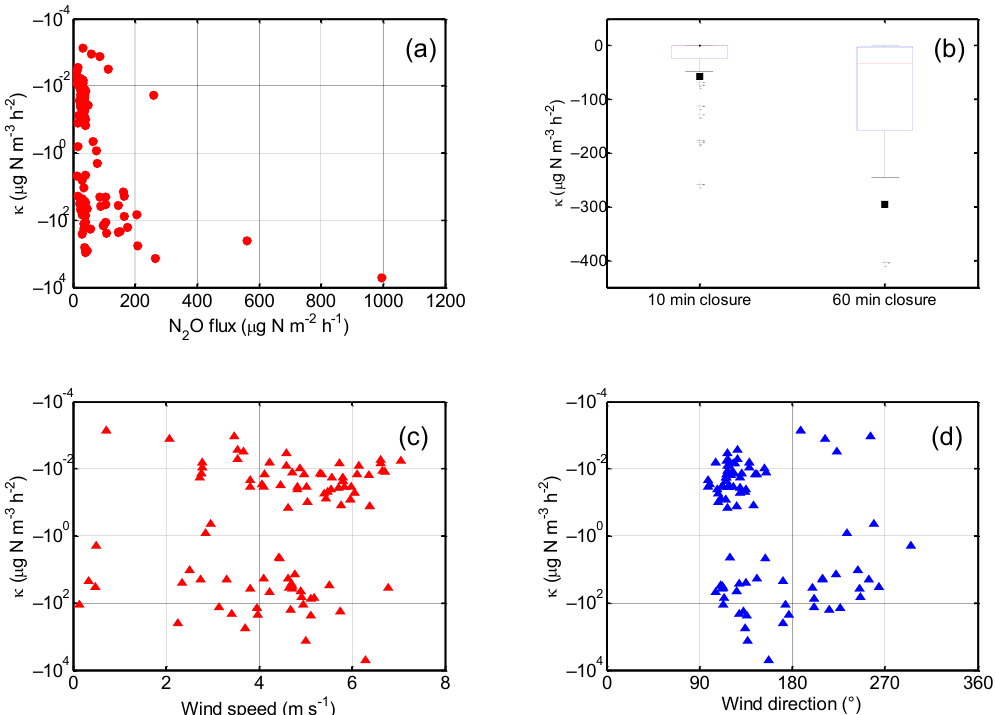
Figure 3. (a) Relationship between κ and N 2 O fluxes calculated with an exponential model (see text for details). The parameter κ indicates the curvature, i.e., the second derivative of the exponential model used for flux calculation. Negative κ values correspond to concave functions, i.e., plateauing (saturating) N 2 O concentration increases (cf. Fig. 2). (b) Box plot of κ values showing the difference between 10 and 60min closure where black squares represent the arithmetic mean, red horizontal lines indicate the median, blue horizontal lines indicate lower and upper quartile values, black whiskers represent the interquartile range, and outliers from this range are plotted as grey crosses. To ensure better readability, the y axis is truncated at − 450µg Nm − 3 h − 2 . Thus, some outliers between − 450 and − 10 4 µg Nm − 3 h − 2 are not shown. (c, d) Relationship between κ and wind speed (c) as well as κ and wind direction (d) . All data are taken from the quantum cascade laser system operated during the Risø campaign. Chambers were closed for 10min at DOY<105.5 and for 60min at DOY>105.5.